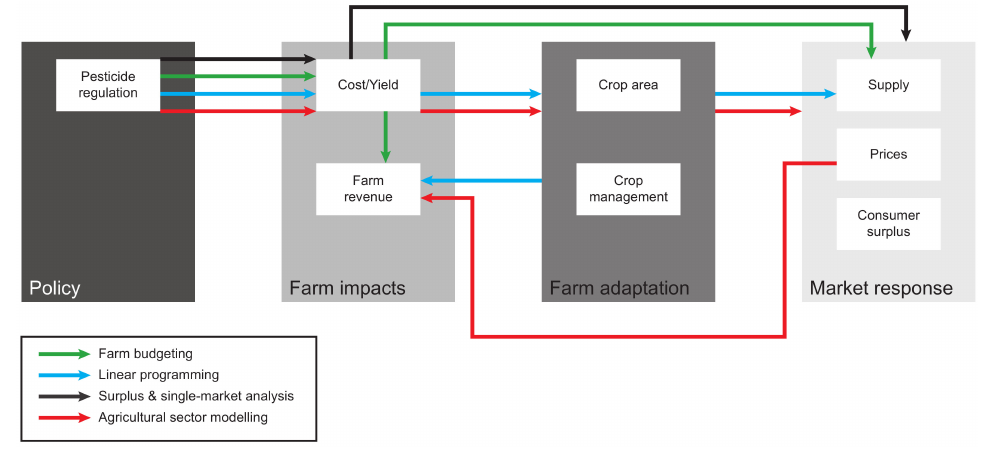
Figure 1. Scope of alternative assessment methodologies for pesticide